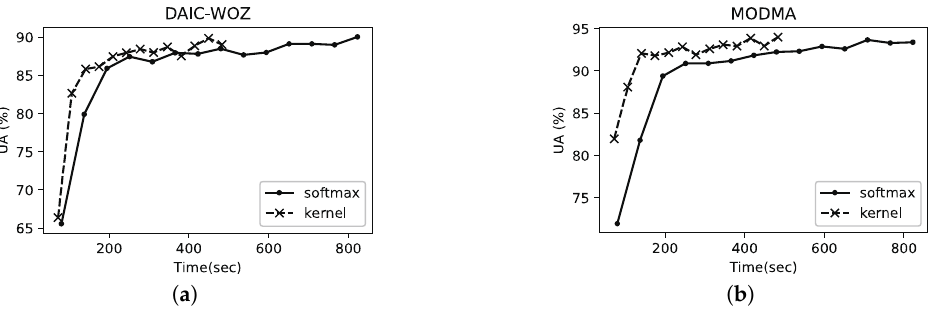
Figure 5. The unweighted accuracies (%) of the transformer module with softmax and kernel setups for different iteration steps in training on the time scale on ( a ) DAIC-WOZ and ( b ) MODMA